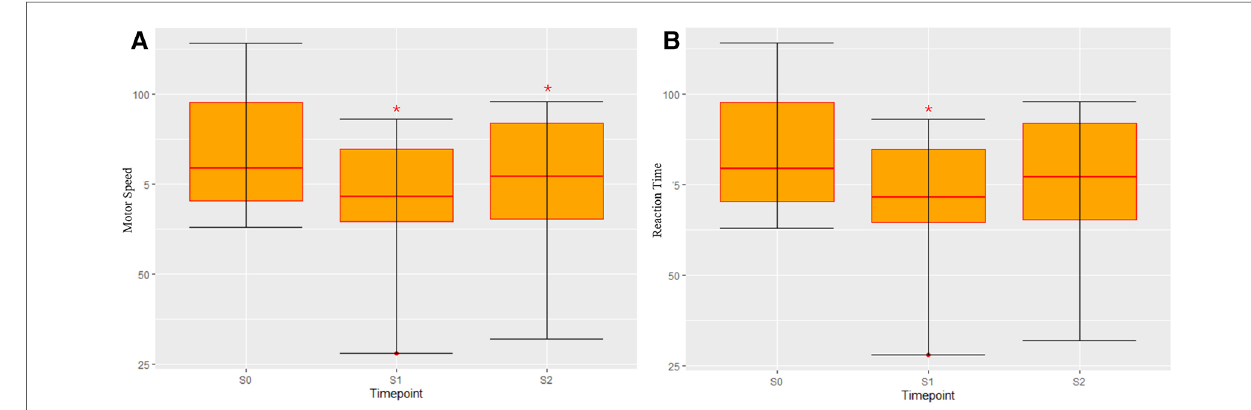
FIGURE 1 Changes in patients ’ performance during the perioperative period. ( A ) Motor speed; ( B ) Reaction time. “ * ” indicates a signi fi cant statistical difference compared to the previous assessment ( p , 0 : 05). S0, before the surgery; S1, in the fi rst month after the surgery; S2, 3 – 6 months after the